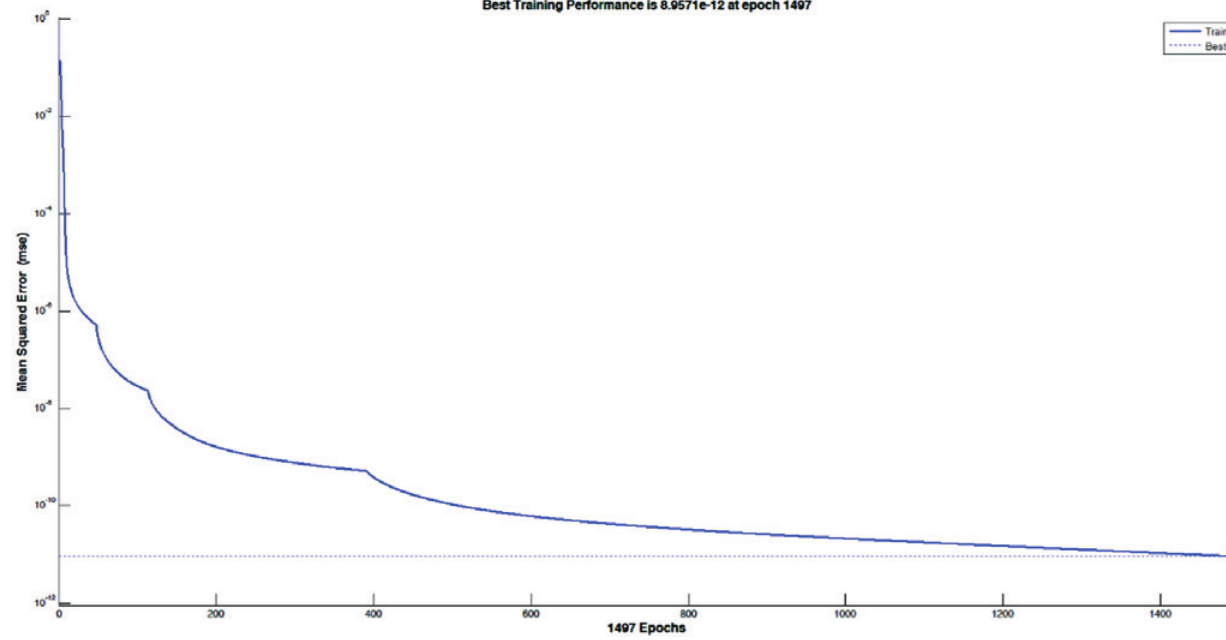
Evolution of Artificial Neural Network training - ANN 20x40x40x1